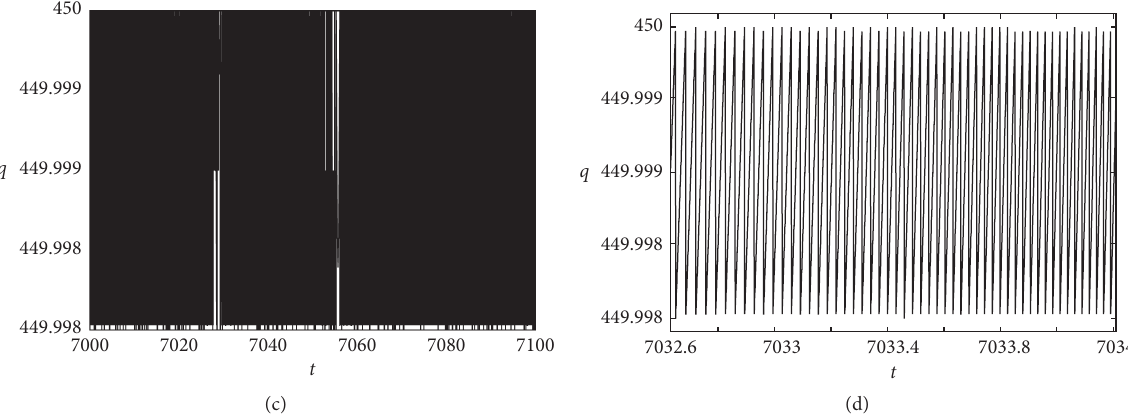
Figure 10: The more irregular oscillation in a broader region of system (10), where the phase portrait is in (a), time histories in (b) and (c), and (d) is the local magnification of (c).